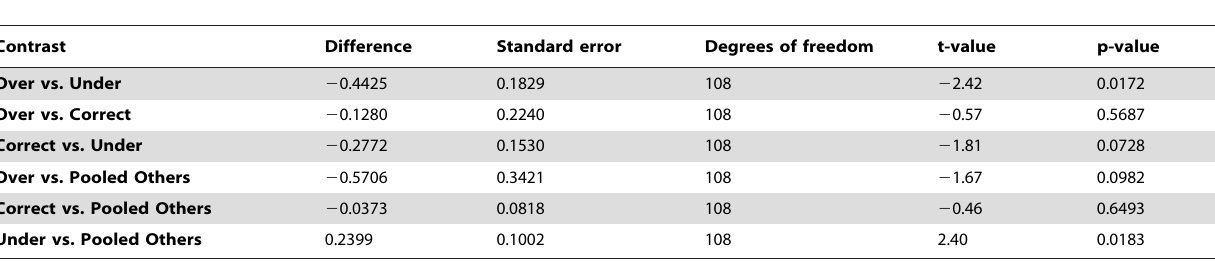
Table 4. Contrasts of average predation-specific mortality between simulations of virtual chipmunks with varying degrees of responsiveness to simulated predation